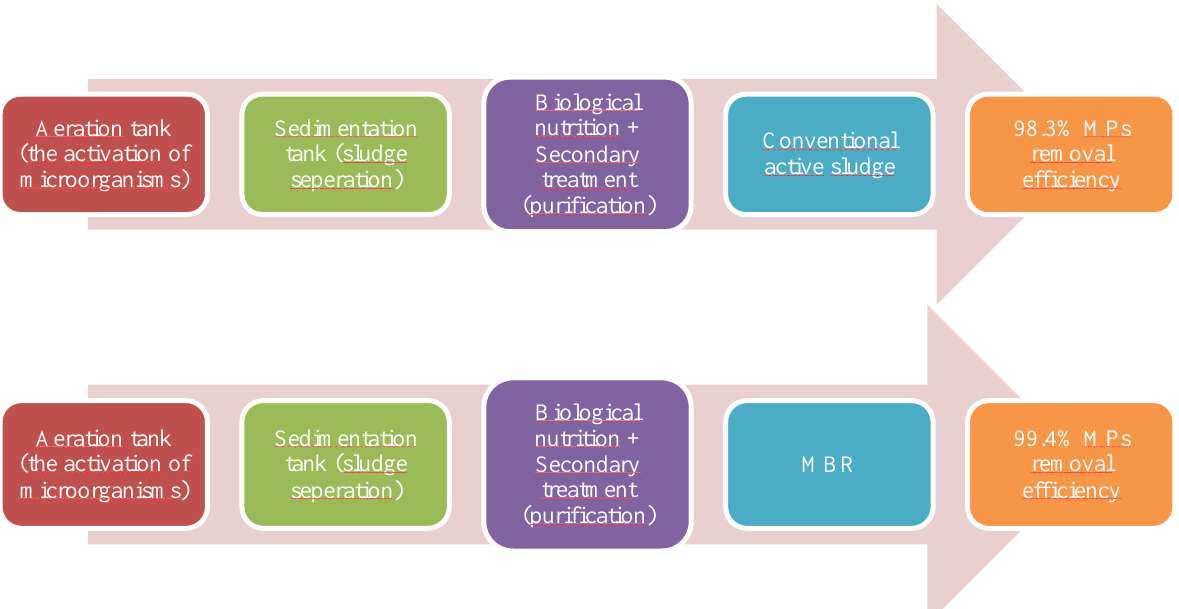
Figure 1. Comparison of removal of MPs in different wastewater treatment